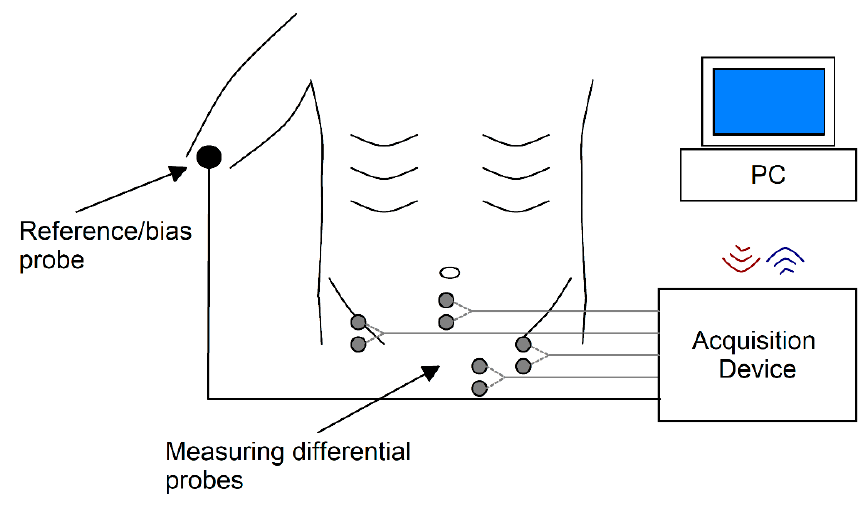
Figure 6. The example of probes placement while measuring.